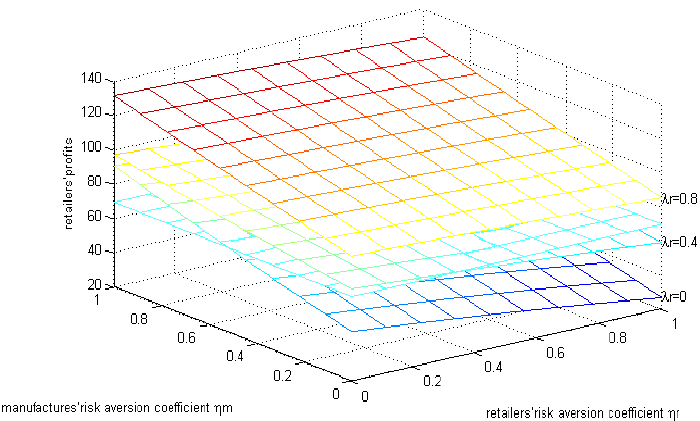
Figure 7. The effects of the risk aversion coefficient and fairness concern coefficient on the retailer’s